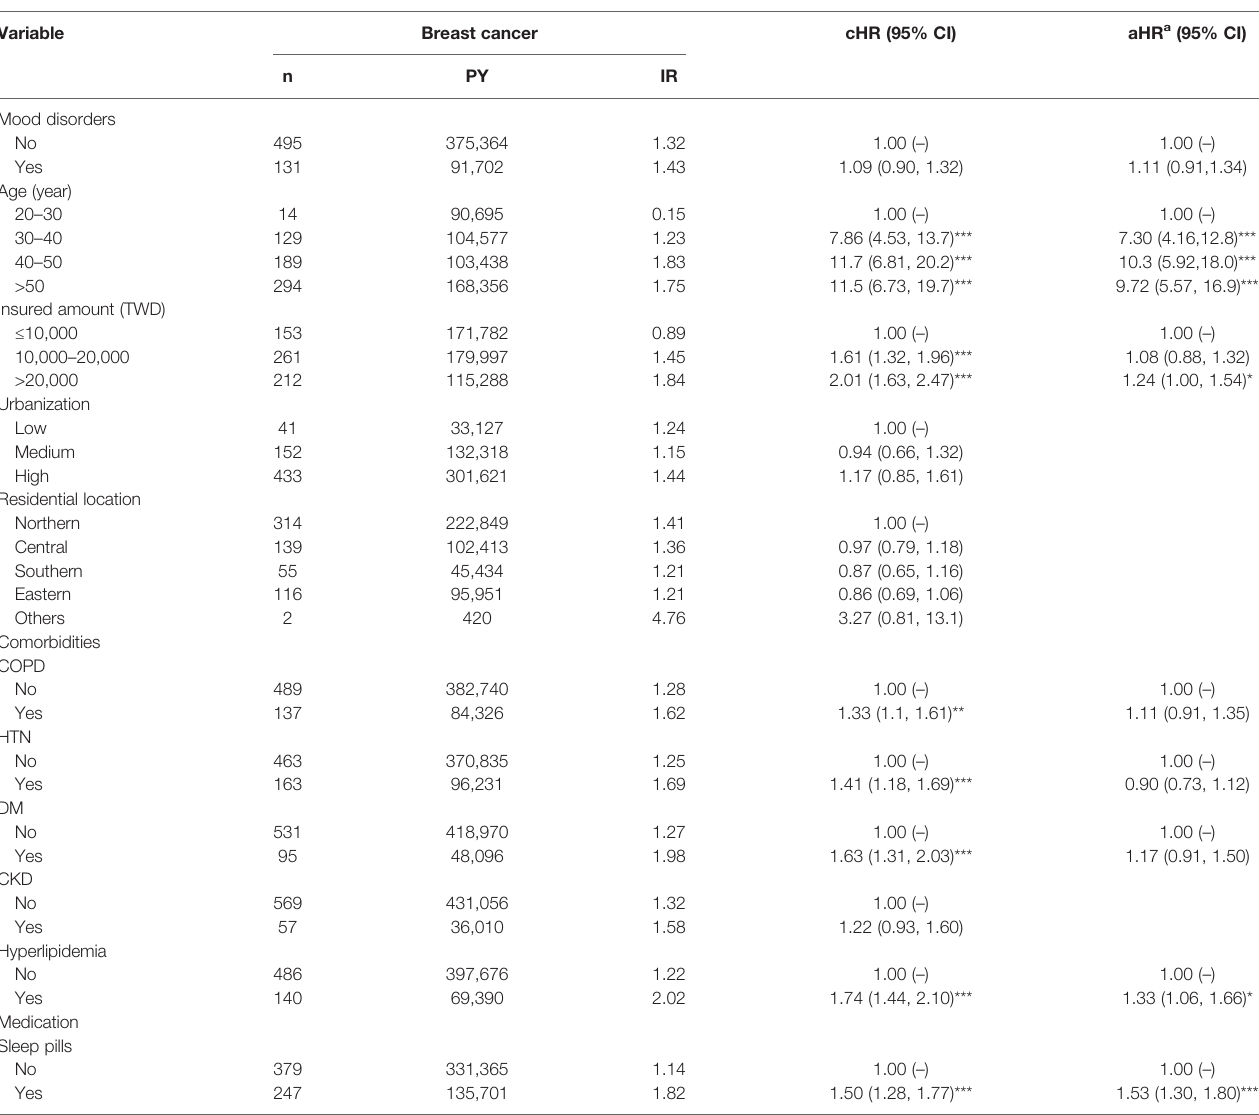
TABLE 6 | The incidence rates and hazard ratios of breast cancer in mood disorder cohort. Variable Breast